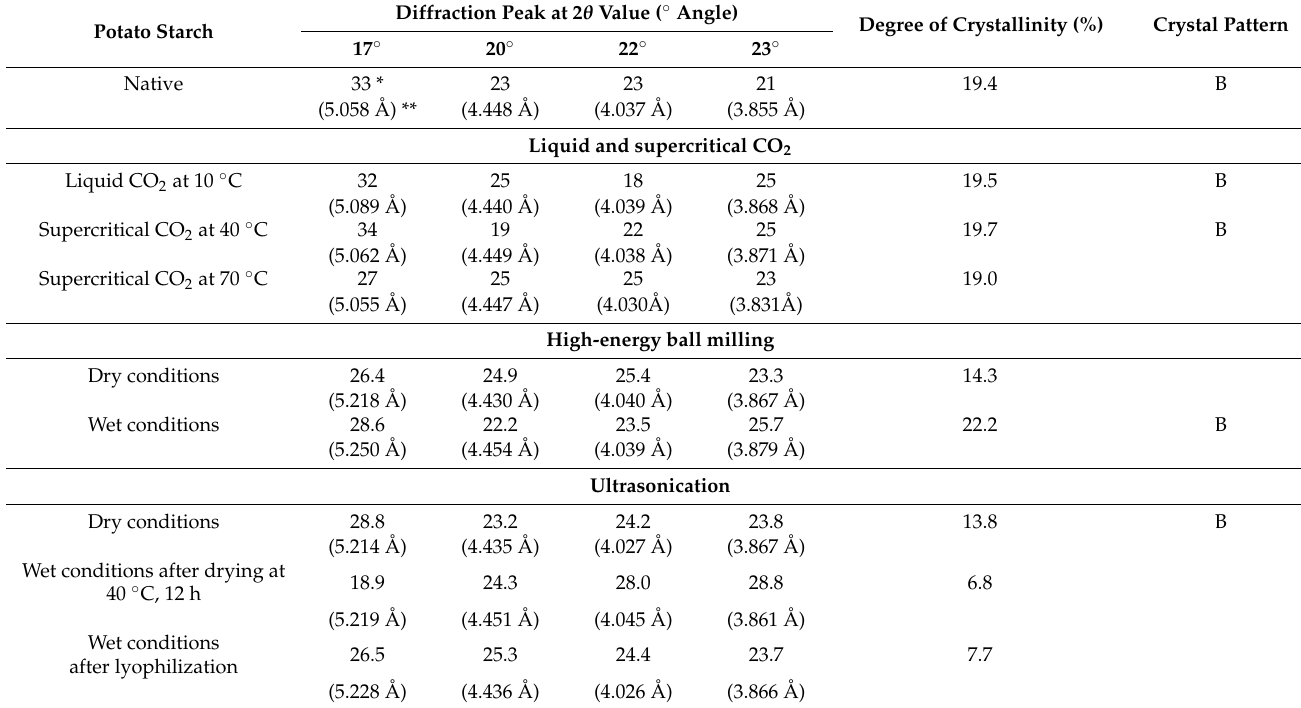
Table 2. X-ray powder diffraction of native and treated potato starch samples. Figure 1. X-ray powder diffraction patterns of ( a ) native and treated starch using liquid and super- Potato Starch critical CO 2 ; ( b ) native and treated starch using ultrasonication; ( c ) native and treated starch using HEBM.